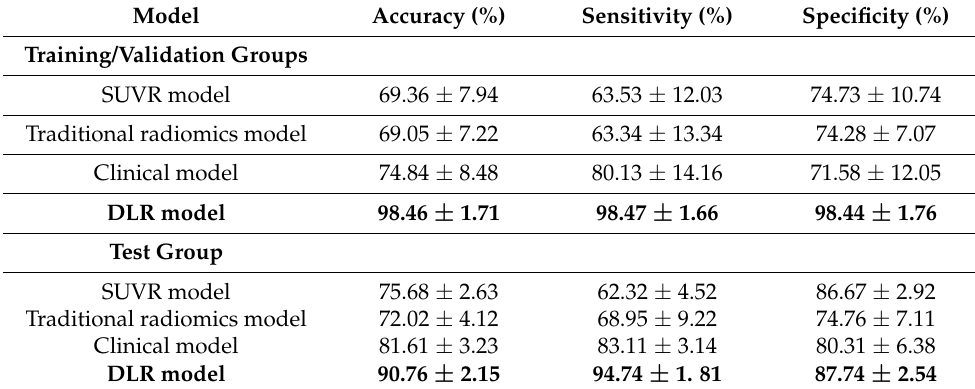
Table 5. The classification performance in NC vs. MCI.